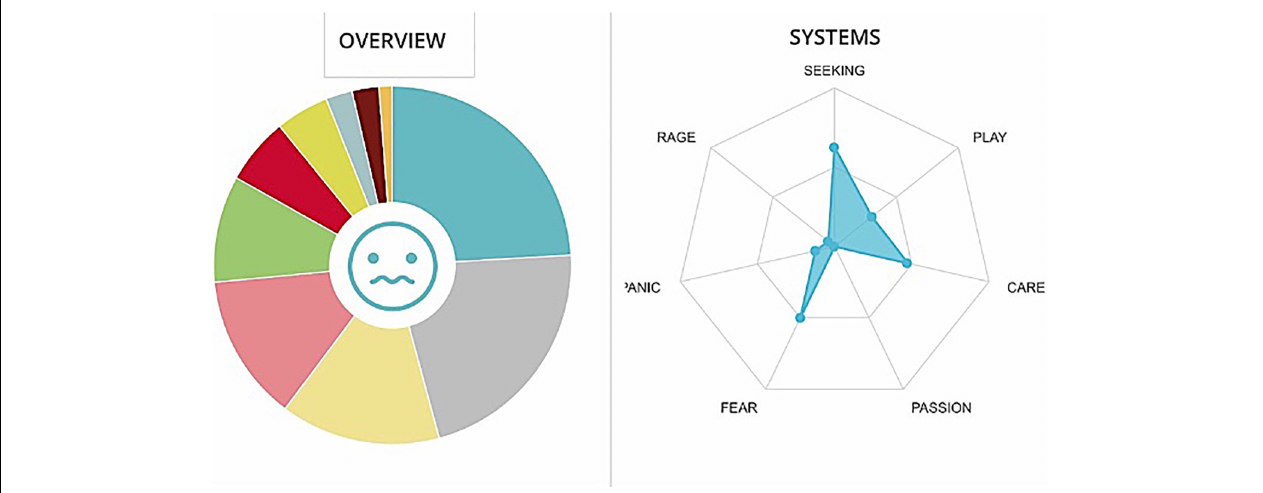
FIGURE 11 | Graphs GD. The cumulative percentages of choice of emotions made by a team are represented in the pie chart (Different colors match to the different emotions as they are displayed in Figure 1 ) while the web graph shows the correspondence between chosen emotions and emotional systems.